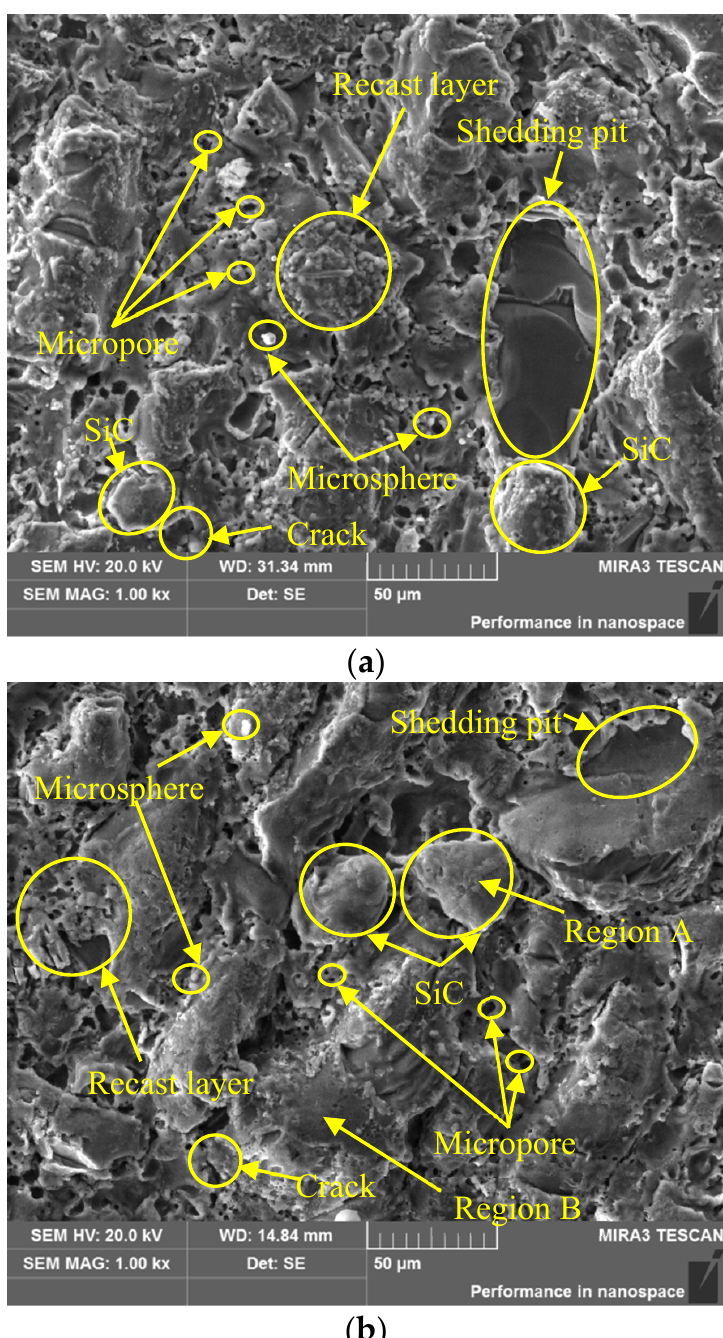
Figure 2. SEM micrographs of the machined surface of SiCp/Al composite. ( a ) No. 1 in Table 4. ( b ) No.4 in Table 4.